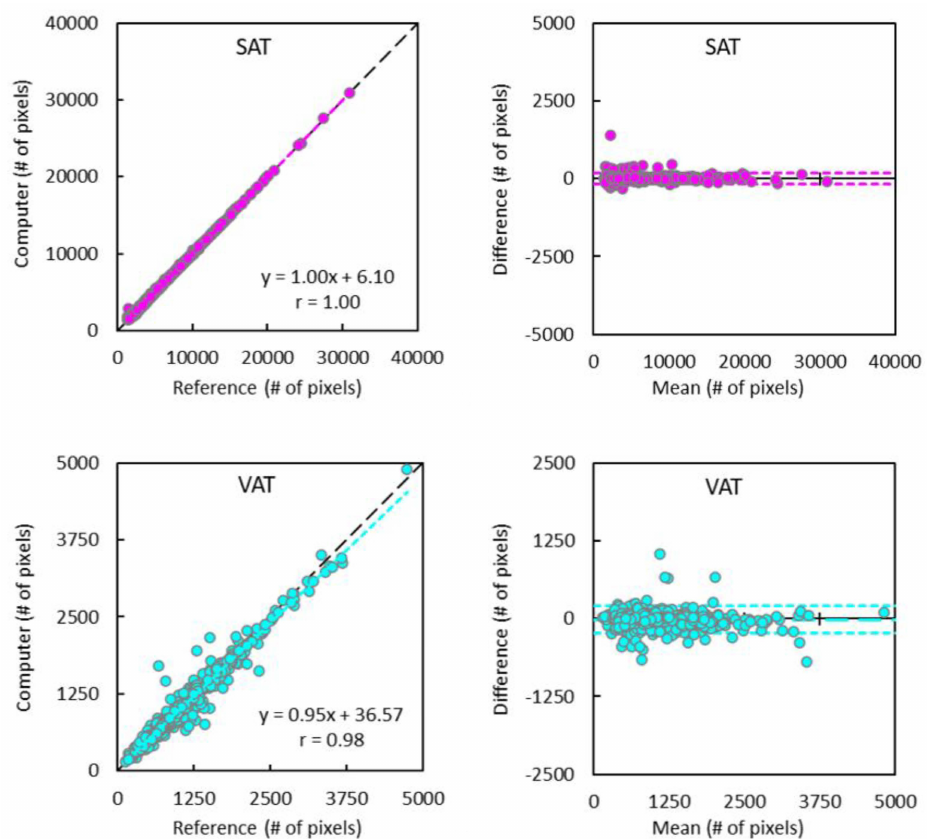
Figure 4. Pearson coefficients and Bland–Altman plots show excellent correlations and good agree- ment between computer (convolutional neural network approach) and reference (human) segmenta- tion of subcutaneous adipose tissue (SAT) and visceral adipose tissue (VAT). The dashed and dotted lines in Bland–Alman plots represent the bias and limits of agreement (mean ± 1.96